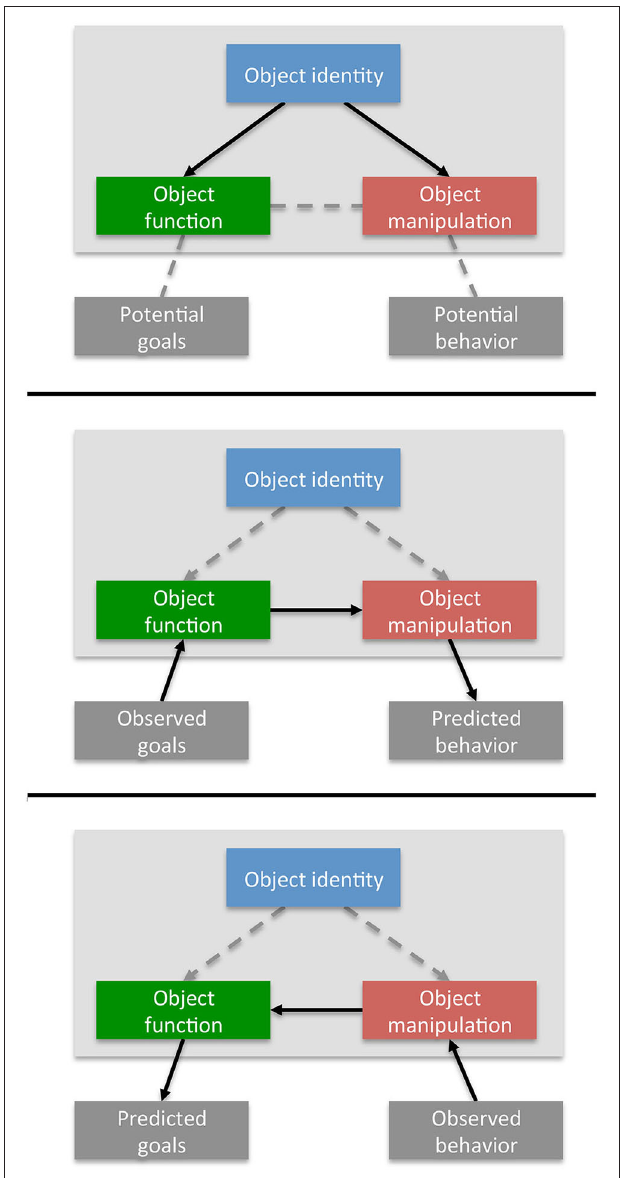
FIGURE 1 | Affordance matching during action observation . Top panel: object identification provides information about what an object is for (function knowledge) and how it has to be manipulated to realize this function (manipulation knowledge). Middle panel: flow of information during action prediction. Inferred goals of an actor activates objects with matching functions. The associated manipulation knowledge predicts forthcoming movements. Bottom panel: flow of information during action interpretation. Observed behavior that matches an object’s manipulation activates the corresponding function, which in turn provides information about the actor’s